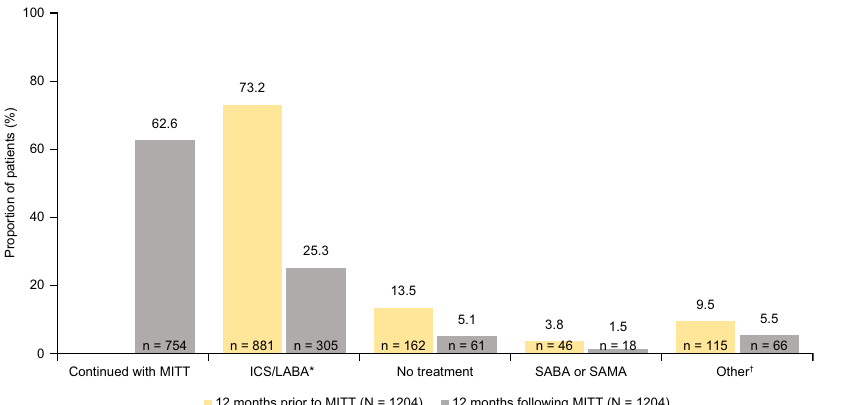
Fig. 3 Treatment patterns 12 months prior to (pre-index) and 12 months following (post-index) MITT initiation in the overall population. Percentages may not total 100% due to rounding. *ICS/LABA category includes: ICS/LABA, ICS/LABA/anti-leukotrienes, ICS/LABA/OCS, ICS/ LABA/OCS/SAMA, ICS/LABA/anti-leukotrienes/OCS; † other category includes: ICS, ICS/LAMA, ICS/anti-leukotrienes, ICS/OCS, ICS/OCS/LAMA, LABA/LAMA, LABA/anti-leukotrienes, LAMA, LAMA/anti-leukotrienes, anti-leukotrienes, OCS, OCS/LAMA, OCS/LAMA/anti-leukotrienes. ICS inhaled corticosteroid, LABA long-acting β 2 -agonist, LAMA long-acting muscarinic antagonist, MITT multiple-inhaler triple therapy, OCS oral corticosteroid, SABA short-acting β 2 -agonist, SAMA short-acting muscarinic antagonist.